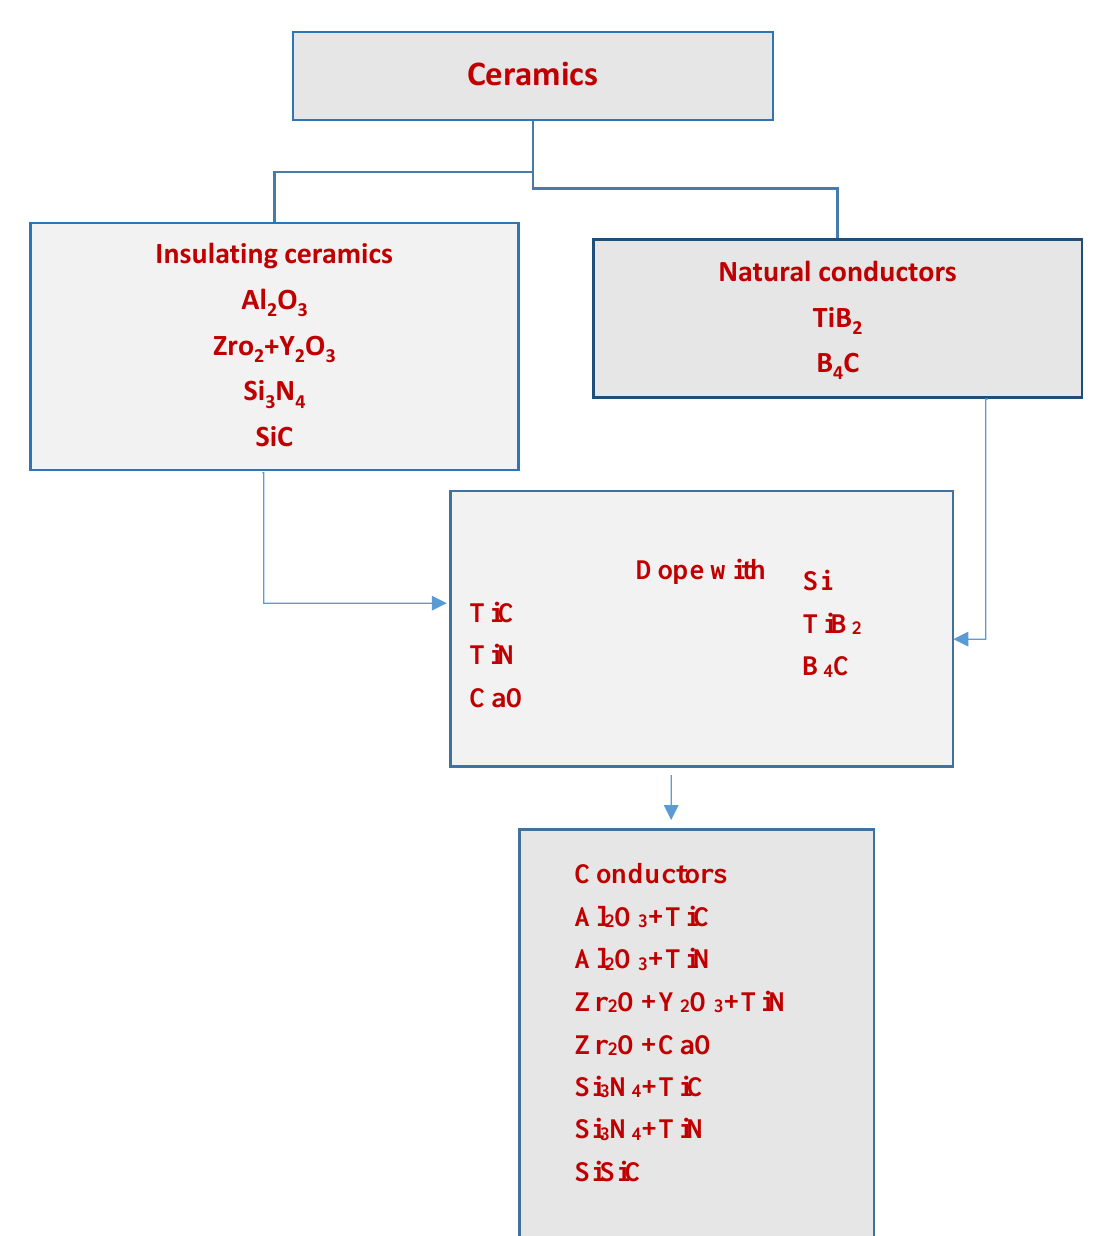
Figure 5. Classification of ceramics materials based on conductivity. (Reproduced with permission from [61]).